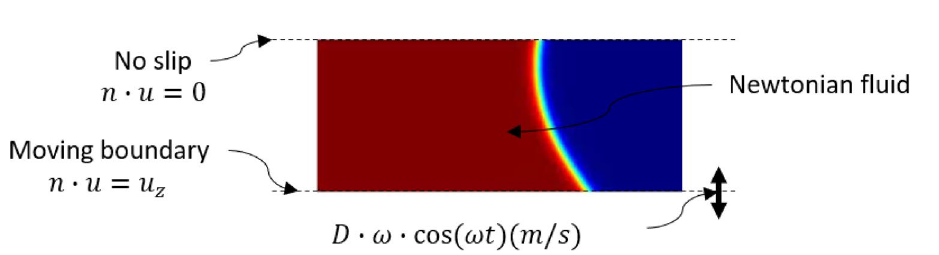
Figure 4. Boundary conditions and assumptions for the liquid deformation